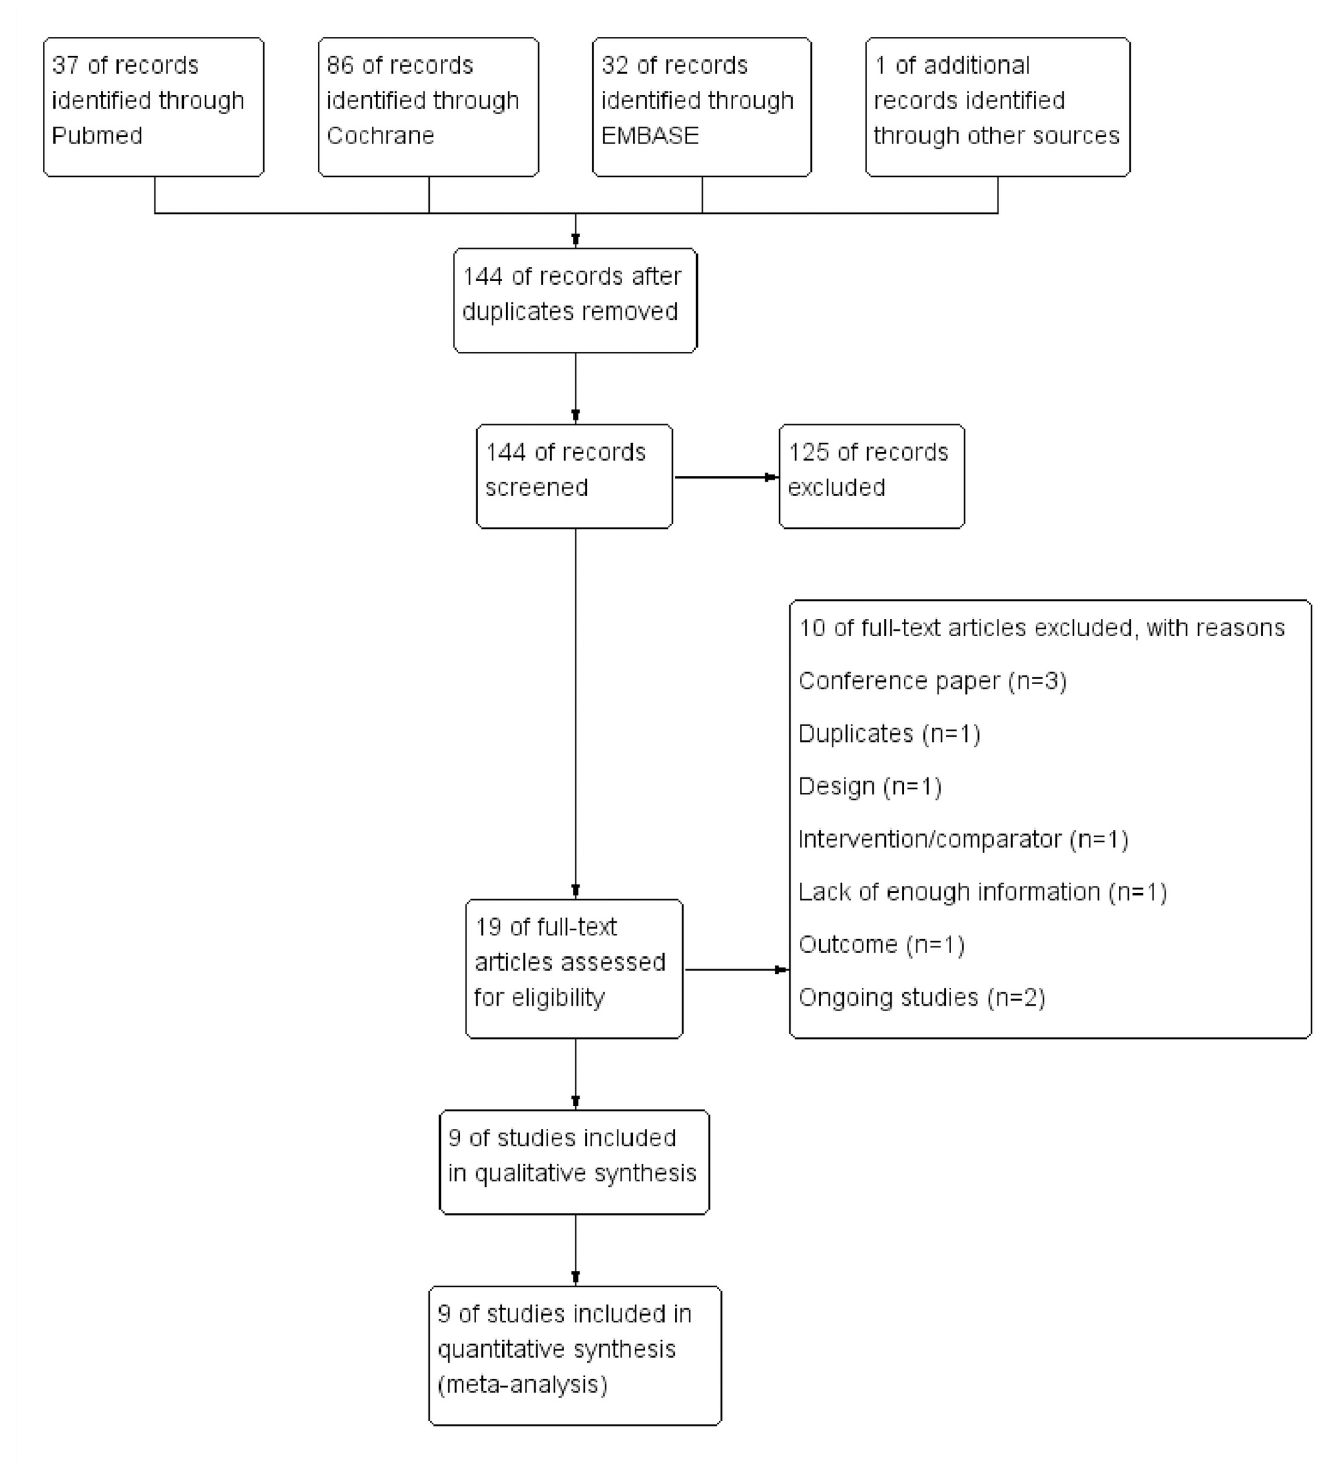
Fig 1. Study flow diagram.